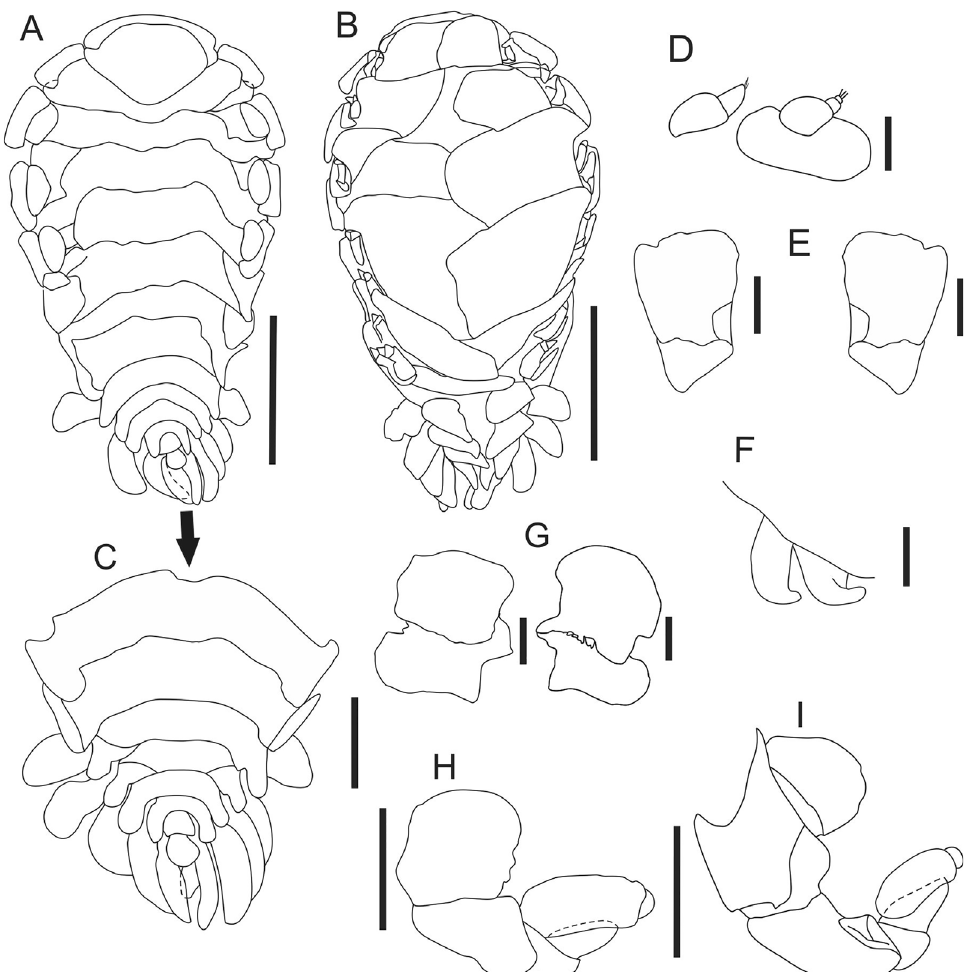
Figure 2. Anuropodione carolinensis Markham, 1974 (MOUFPE 18874), Potiguar Basin, station #MT–61, 418 m, Rio Grande do Norte, northeastern Brazil. (A) Mature female, dorsal; (B) mature female, ventral; (C) abdomen and pleotelson, detail; (D) antenna and antennule; (E) maxilliped (left and right); (F) barbula; (G) oostegite 1; (H) pereopod 1; (I) pereopod 7. Scale bar = A, B, 5 mm; C, 2 mm; D–G, 0.5 mm; H, I,1 mm.